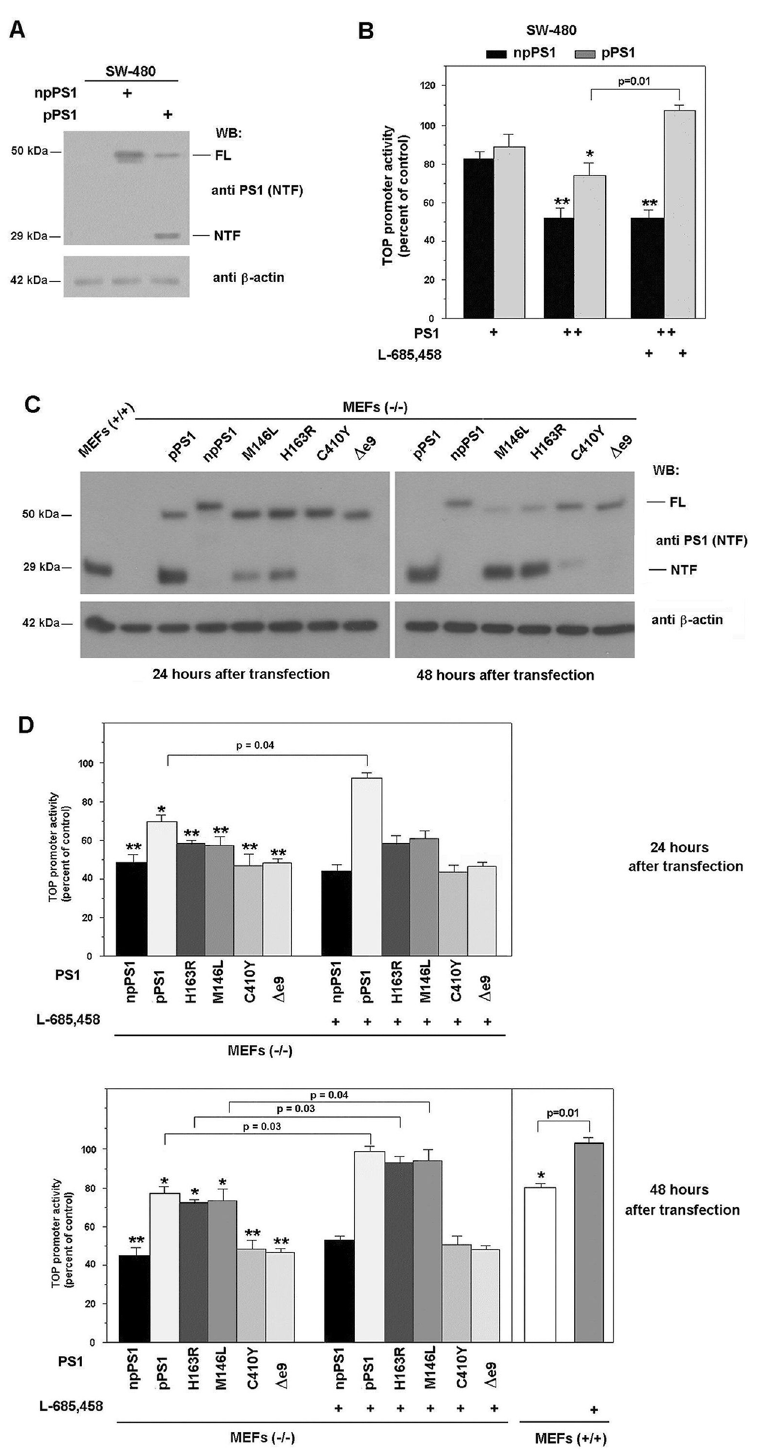
Fig 1. Processed and non-processed PS1 block β -catenin (cid:1) Tcf-4-dependent transcription differently. SW-480 (A,) and MEF PS ( − / − ) cells (C) were transfected with 5 μ g of pcDNA3 plasmid containing either Myc/His -tagged PS1 (npPS1), wild-type PS1 (pPS1), the indicated mutants, or empty vector as a control. After 48 hours (A) or at the indicated times (C), cell extracts were prepared as described in Materials and Methods . 50 μ g of untransfected or transfected total cell extracts were analyzed by SDS-PAGE and